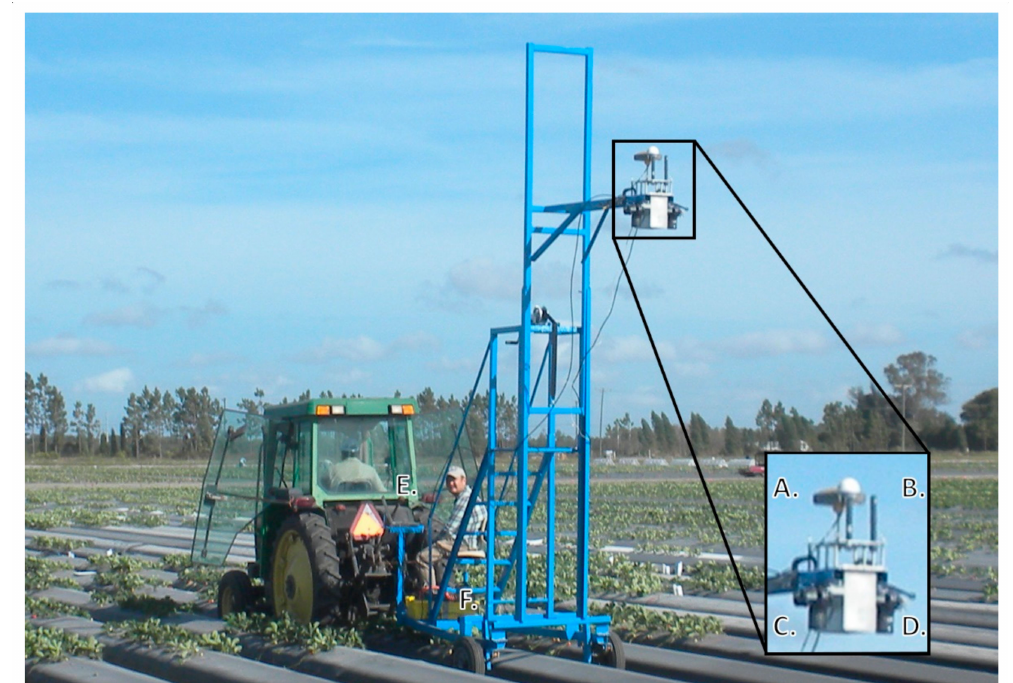
Figure 3. Imaging of strawberry plots using an imaging platform built in this study. The platform is equipped with ( A ) timing GPS, ( B ) Survey-quality GNSS receiver, ( C ) Nikon D300 RGB, ( D ) Nikon D300 IR, ( E ) synchronization hardware and acquisition software (laptop), and ( F ) camera trigger box